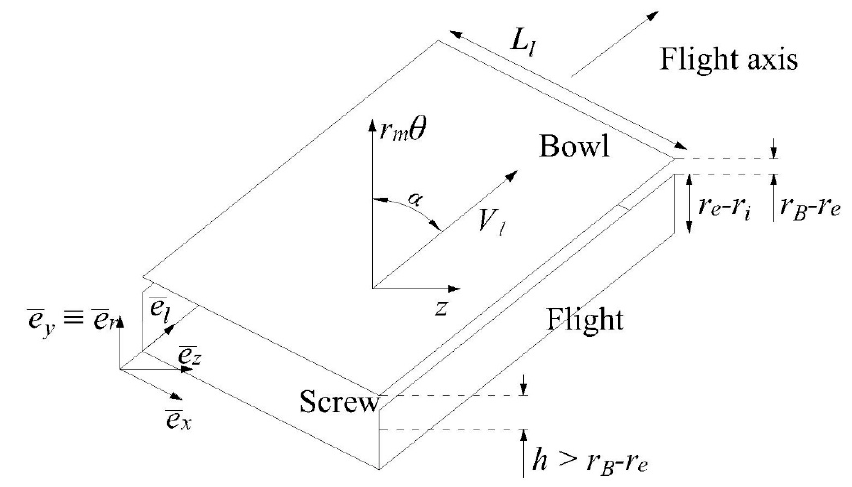
Figure 3. Coordinate system of screw